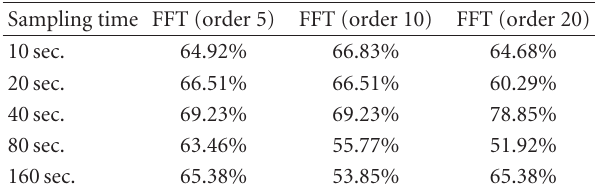
Table 2: Test results using di ff erent sampling time and FFT